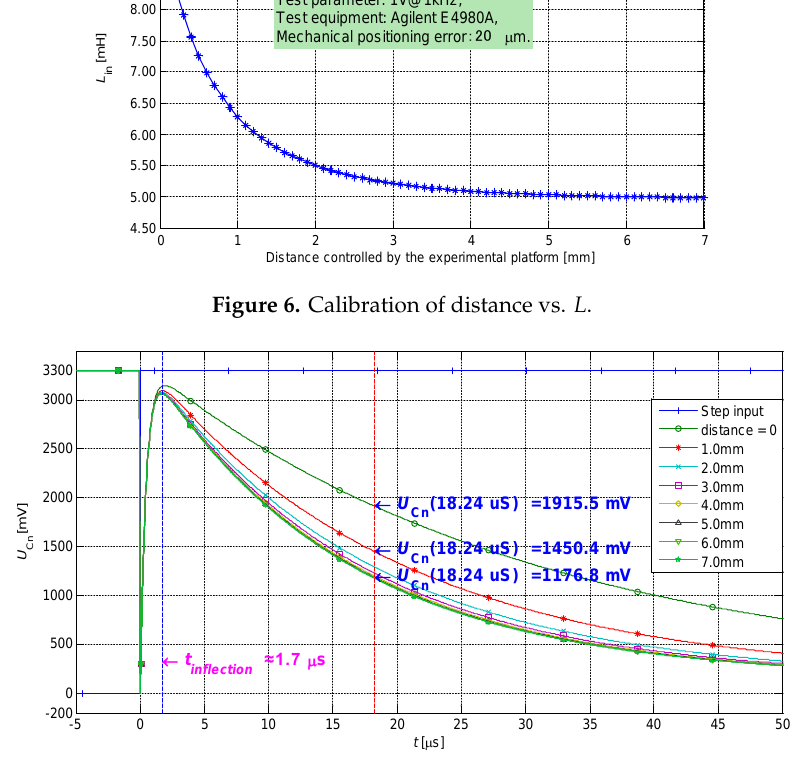
Figure 7. Response waveforms of the inertial system.